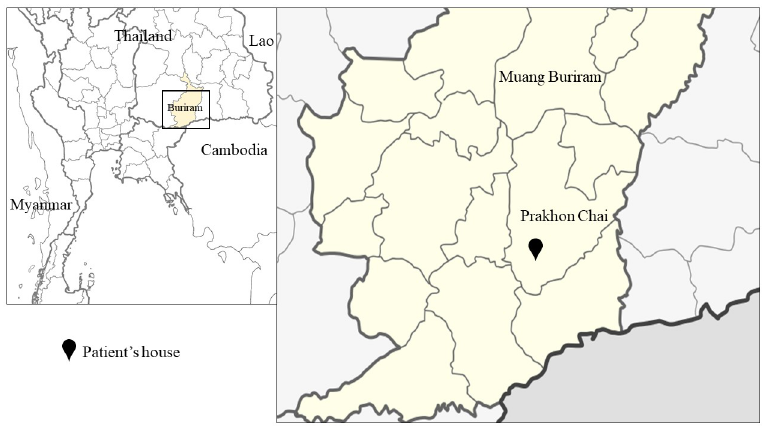
Fig 1. Location of the patient’s residence in Buriram, Northeast Thailand. Maps of the study region were created using ArcGIS software version 10.3.1.